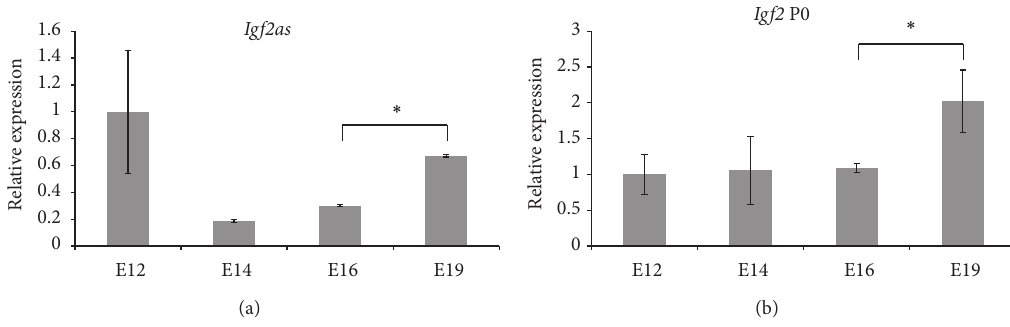
Figure 5: Quantification of Igf2 P0 and Igf2as expression levels in wild-type placentas. Quantifications of Igf2 P0 (P0) and Igf2as transcripts levels in wild-type placenta (WT) at different embryonic stages (E12, E14, E16, and E19). The results are expressed in relative expression. Each bar represents the mean of three samples analyzed in triplicate. The standard deviation for each bar is indicated by error bars. ∗ 𝑃 < 0.05 .